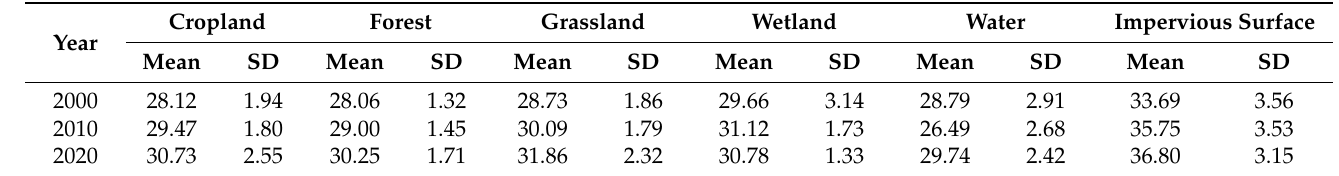
Table 5. Mean and SD of LST for each land type from 2000 to 2020.